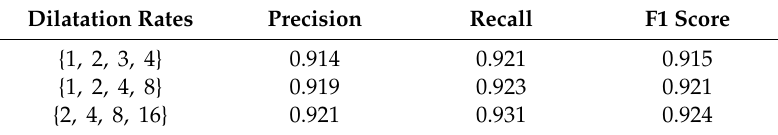
Table 3. Experimental results for di ff erent dilation rates on AigleRN database. Table 2. Experimental results for different dilation rates on CFD database.